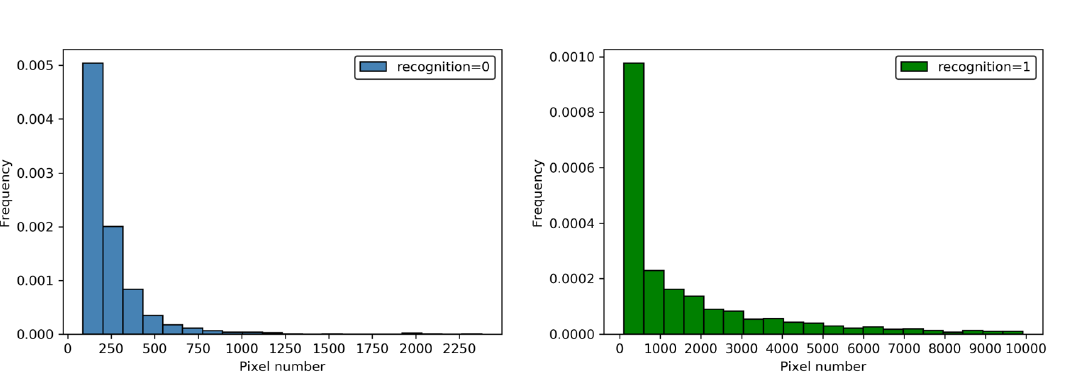
Figure 7. The pixel number distribution of envelope